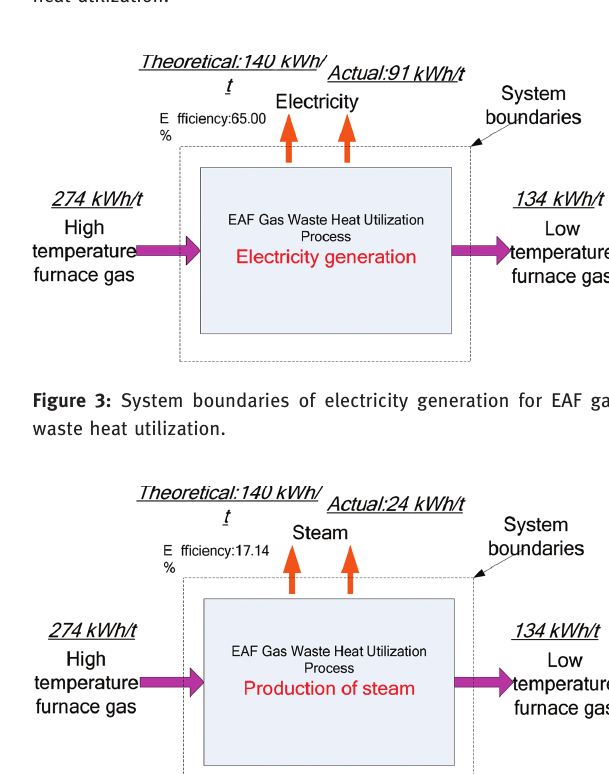
Figure 2: System boundaries of scrap preheating for EAF gas waste heat utilization.